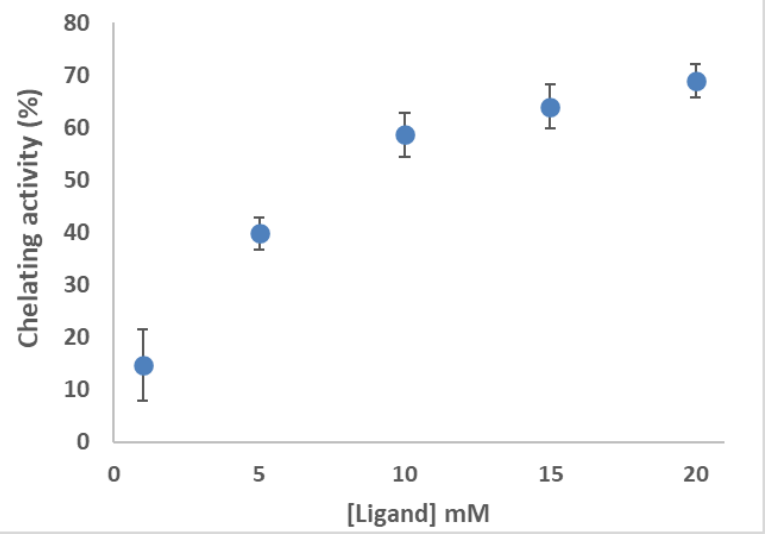
Figure 4. Chelating activity for Cd(II) at different concentrations (1–20 mM).